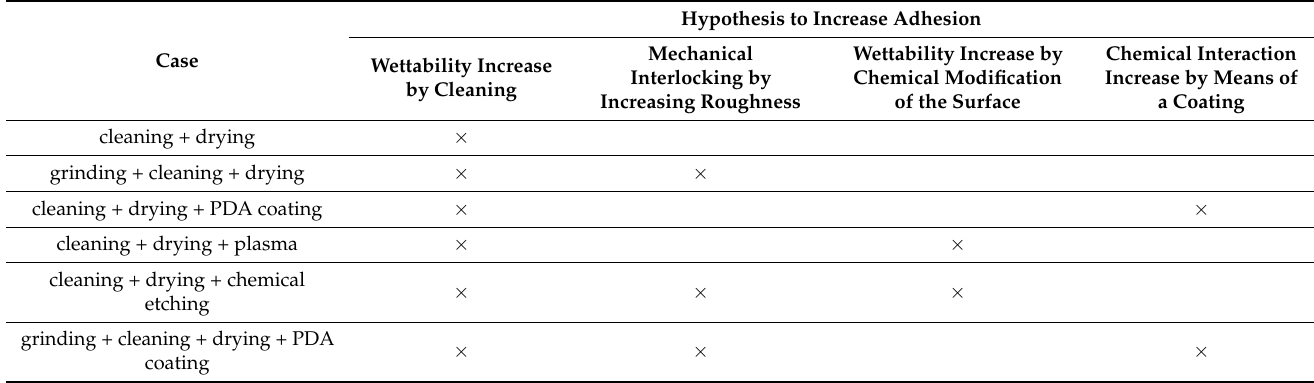
Table 4. The six investigated cases and related hypotheses on